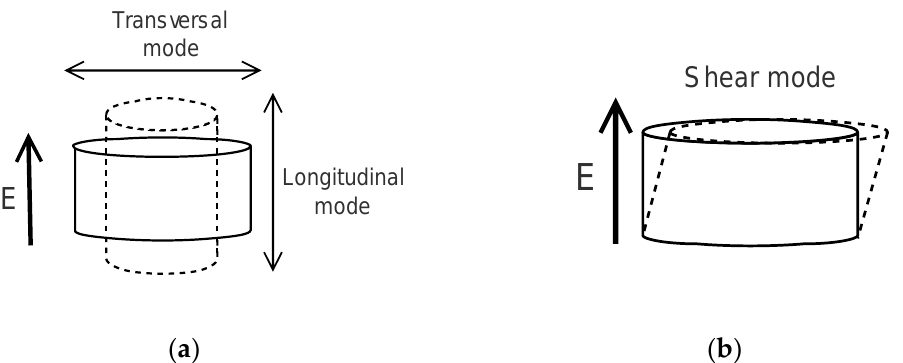
Figure 2. Deformation of the piezoelectric actuator. ( a ) Longitudinal and transversal mode; ( b ) shear mode.